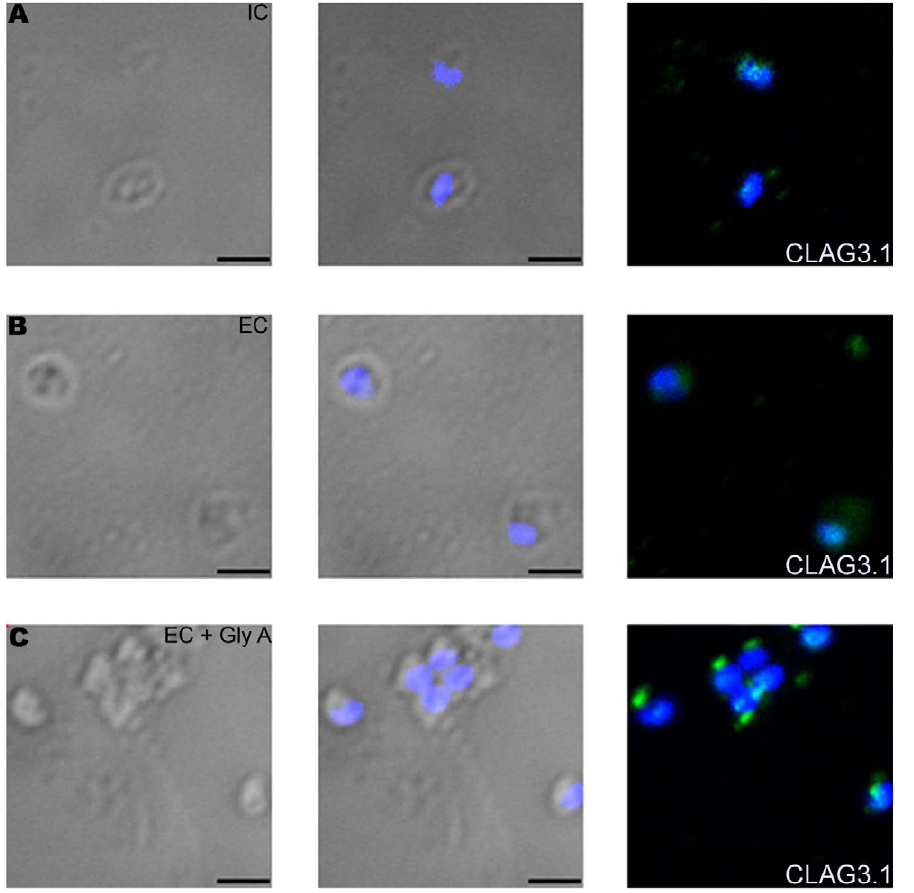
Figure 7. Expression of CLAG3.1 on merozoite surface detected by immunofluorescence assay (IFA) in response to interaction with glyA. Expression of rhoptry protein CLAG3.1 on surface of P. falciparum merozoites isolated in IC buffer (IC) ( A ) or following transfer to EC buffer (EC) ( B ) or following transfer to EC buffer containing glyA (EC + GlyA) ( C ) detected by IFA using anti-CLAG3.1 rabbit sera followed by FITC-conjugated (green) anti-rabbit IgG goat sera. Nuclear DNA was counterstained with DAPI (blue). Bright field, bright field merged with DAPI staining and merged fluorescence images (DAPI and FITC) are shown. Black bar indicates 2 m m.